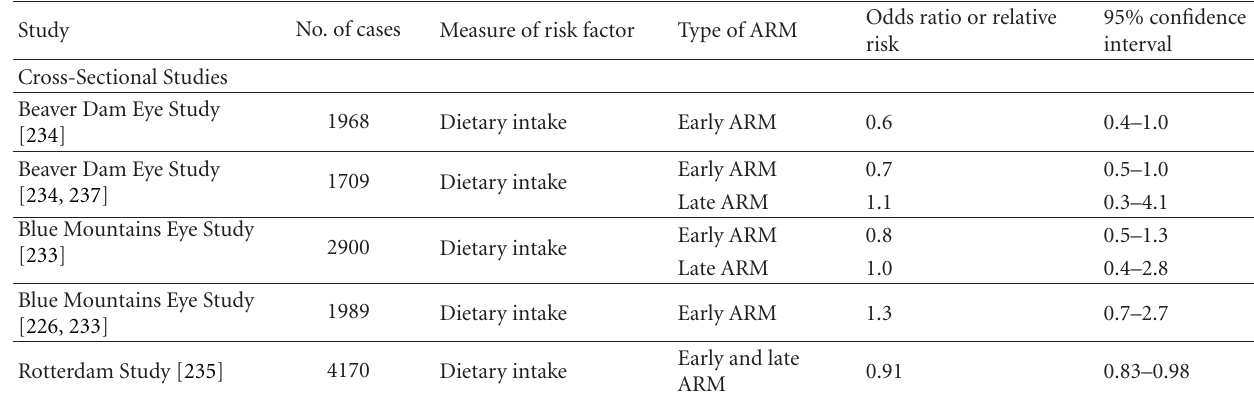
Table 13: Studies investigating the relationship between zinc and risk for ARM.